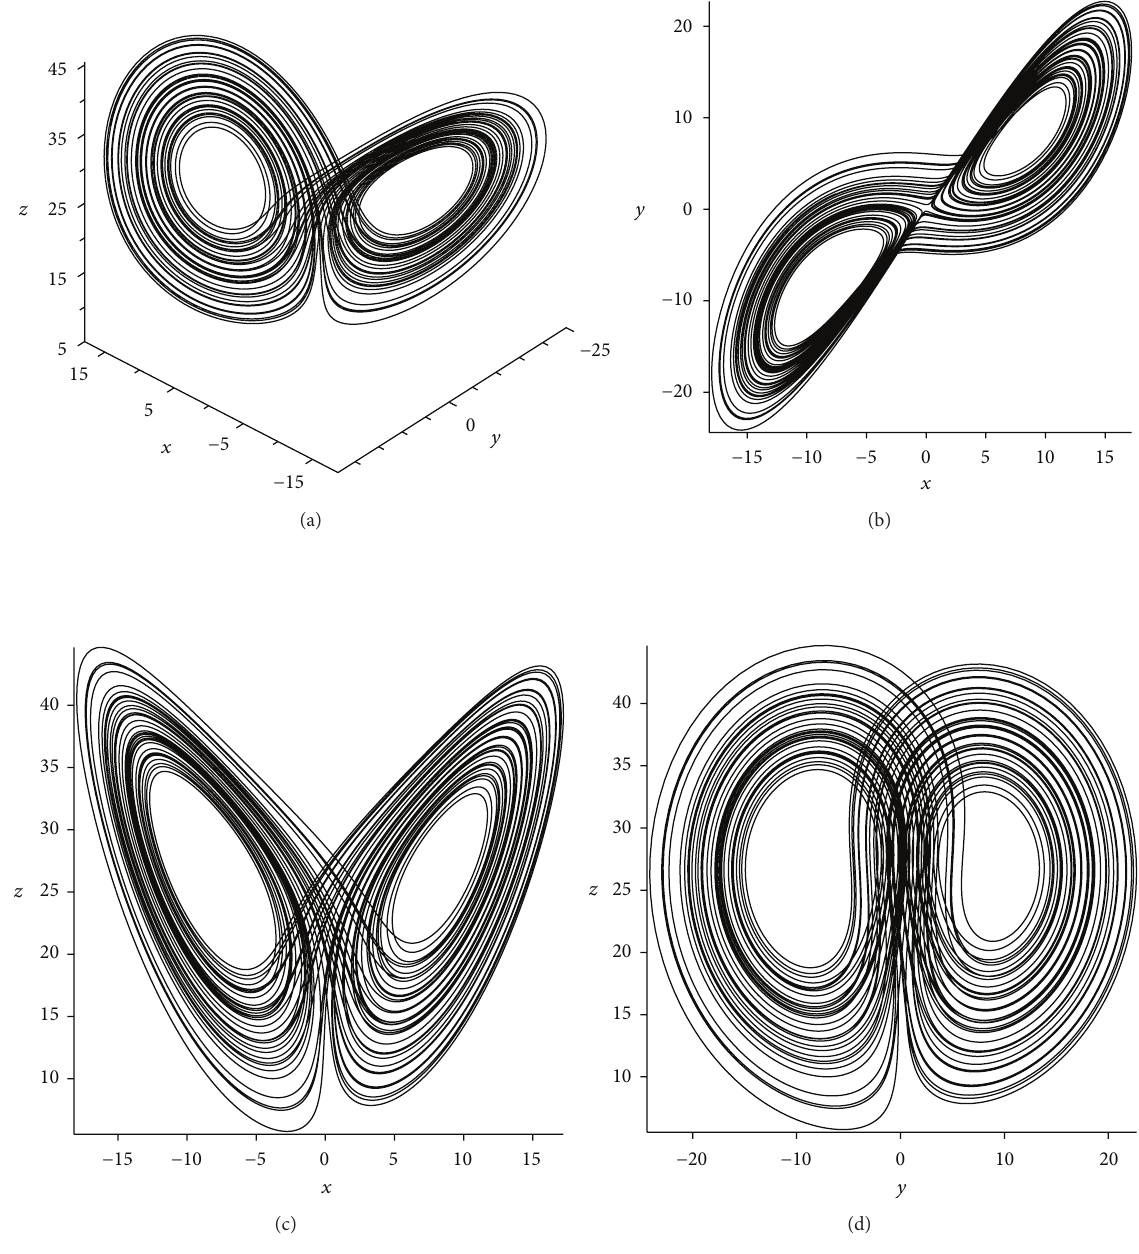
Figure 2: Typical dynamical behavior of three-dimentsional Lorenz system. (a) Projection in (𝑥,𝑦,𝑧) space; (b) projection in (𝑥,𝑦) space; (c) projection in (𝑥,𝑧) space; (d) projection in (𝑦,𝑧) space.